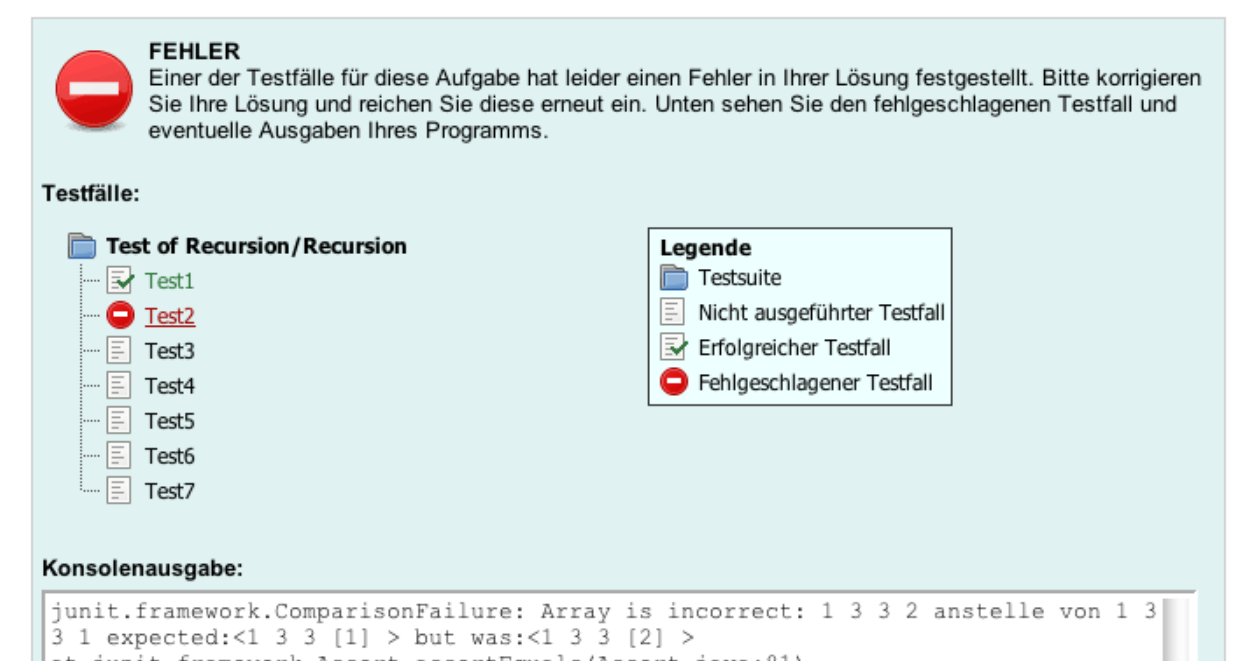
Figure 4. Example validation failure output for code submitted to the WebTasks